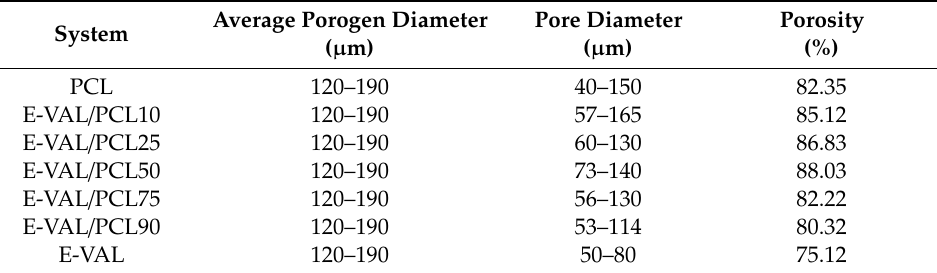
Table 5. Pore diameters and porosity of pure PCL, E-VAL and E-VAL / PCL sca ff olds.